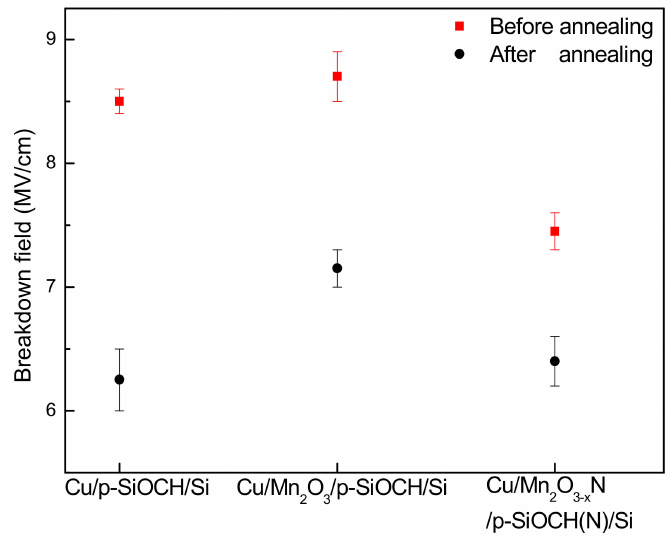
Figure 4. Comparison of breakdown fields of various Cu-gate MIS capacitors before and after annealing. After thermal stress, C-V characteristics were measured again. Normalized C-V curves for the barrier-free and barrier capped capacitor samples before and after thermal stress (450 compared, and the shifts of their flat-band voltages (V fb ) were determined, as presented in Figure 5. The data presented here are the average values from three measurements for di ff erent capacitor samples. After thermal stress, the barrier-free capacitor sample exhibited a larger V fb shift with a negative direction. Additionally, its accumulation capacitance obviously decreased. These